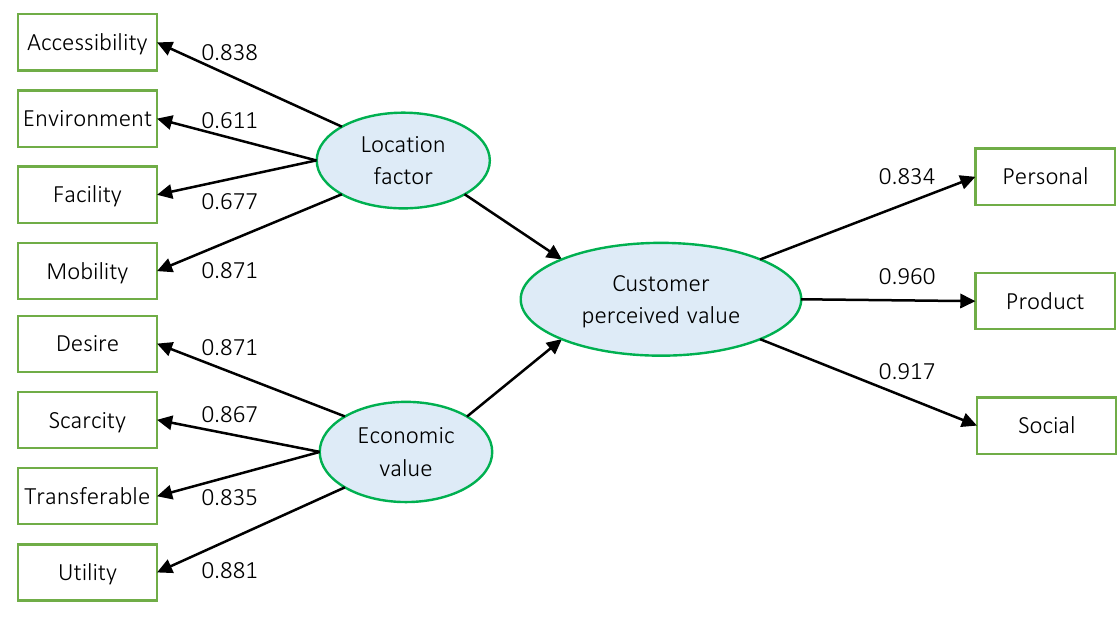
Figure 1. Outer loading research